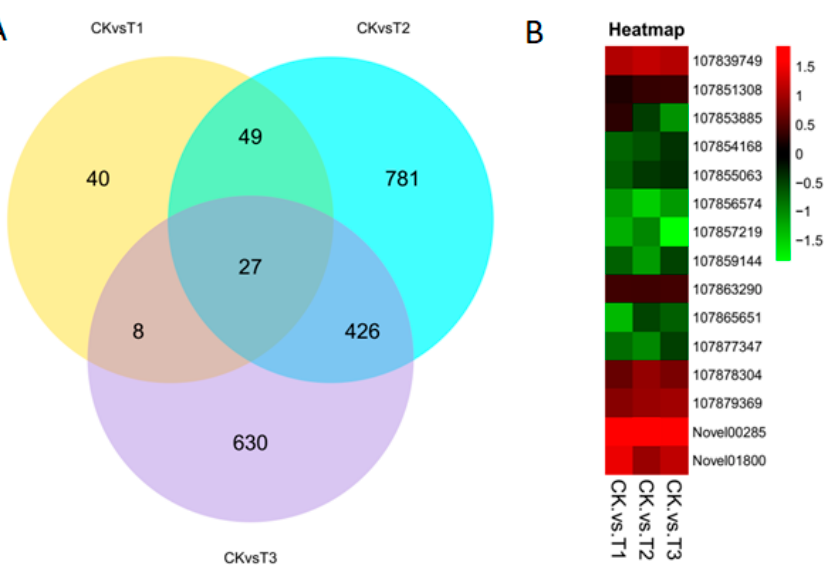
Figure 4. Venn diagram and cluster analyses of DEGs in CK vs. T1, CK vs. T2, and CK vs. T3. ( A ) Venn diagram showing the overlapped DEGs in three comparison groups. ( B ) Clustered heat maps on the right show the differential expression levels of overlapped DEGs in these groups.